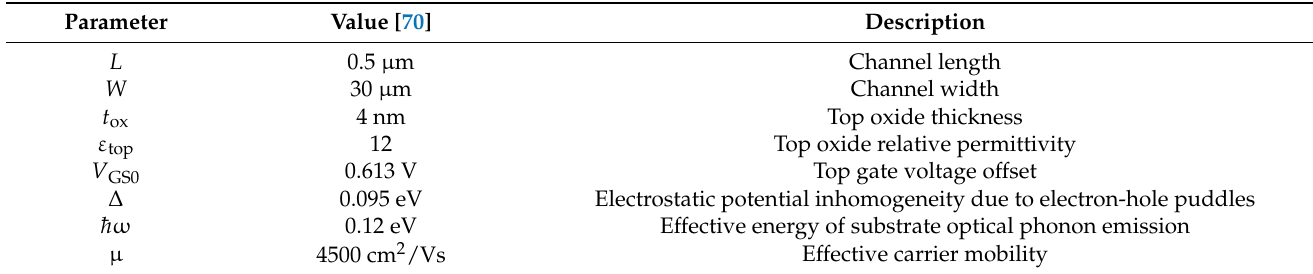
Table 2. Input parameters of the circuit model at the nominal design point.